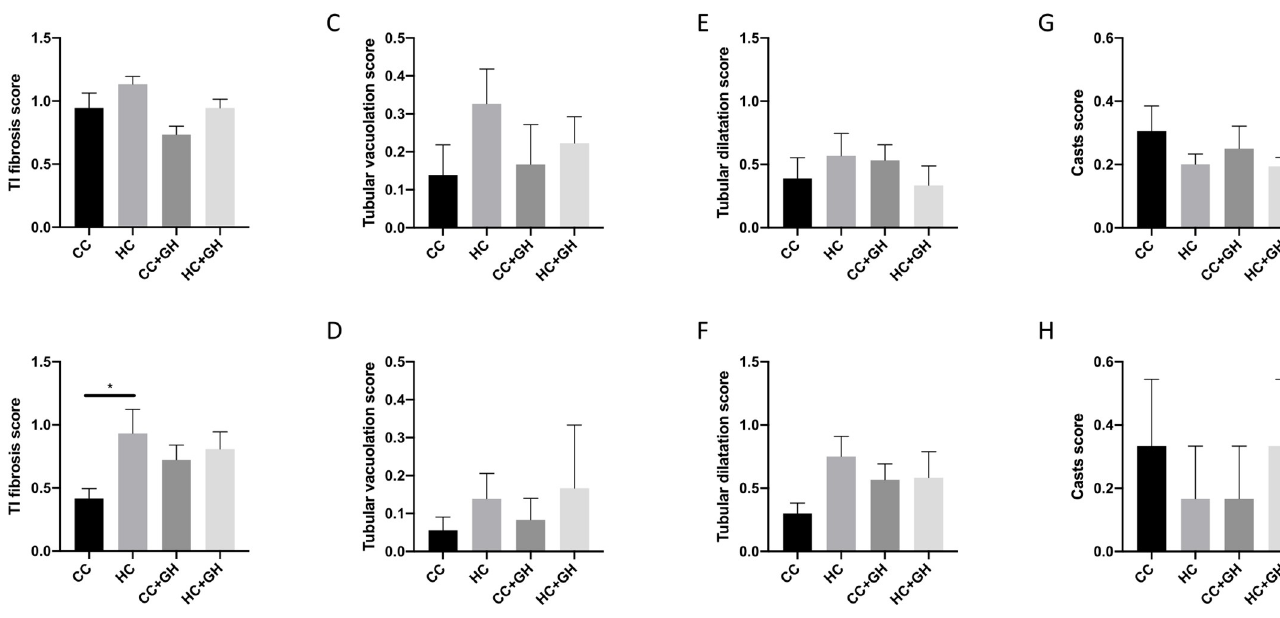
PLOS ONE | https://doi.org/10.1371/journal.pone.0248854 March 18,